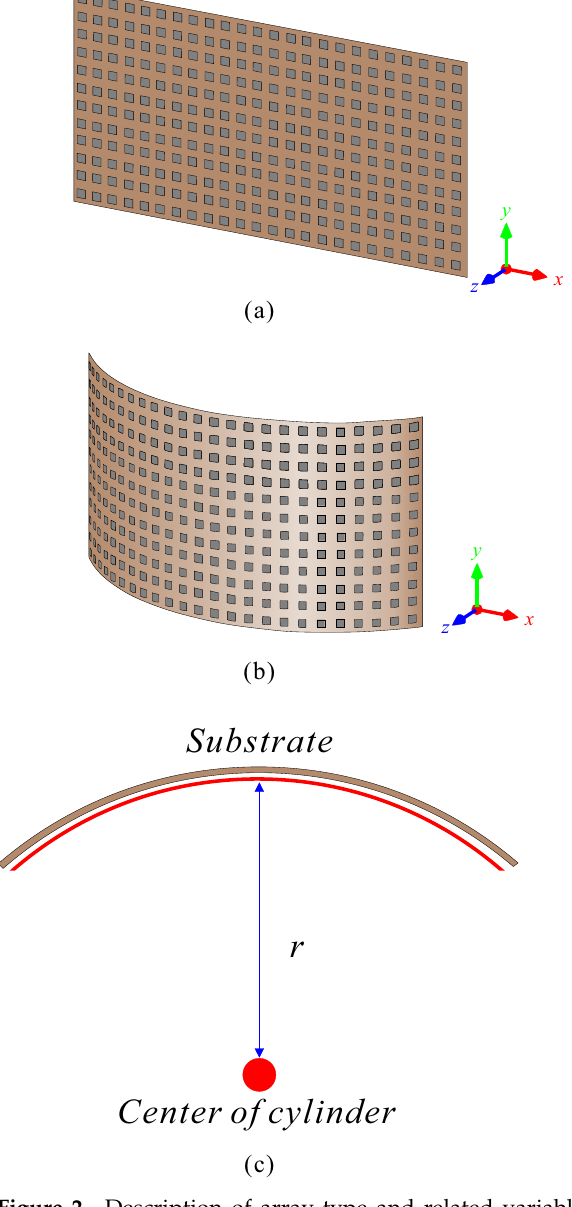
Figure 2. Description of array type and related variables: ( a ) 12 × 24 planar array, ( b ) 12 × 24 conformal array, ( c ) description of variable r